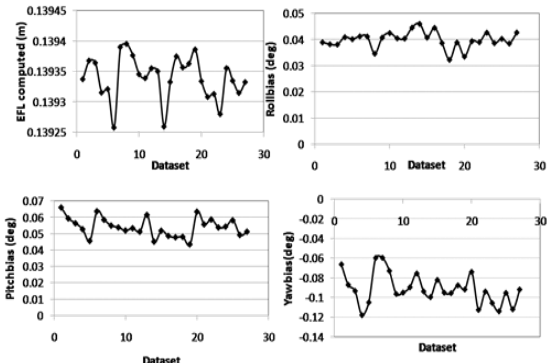
Figure 9 Payload alignment angles and Effective focal length computed for L3 datasets